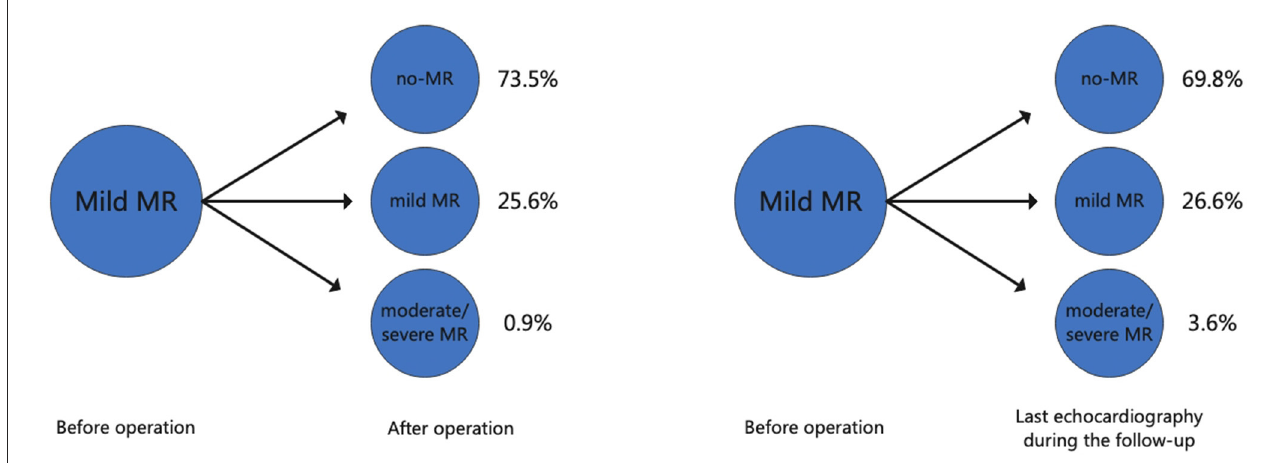
FIGURE1 The changes in the degree of mitral regurgitation after aortic valve surgery and during the follow-up. MR, mitral regurgitation.